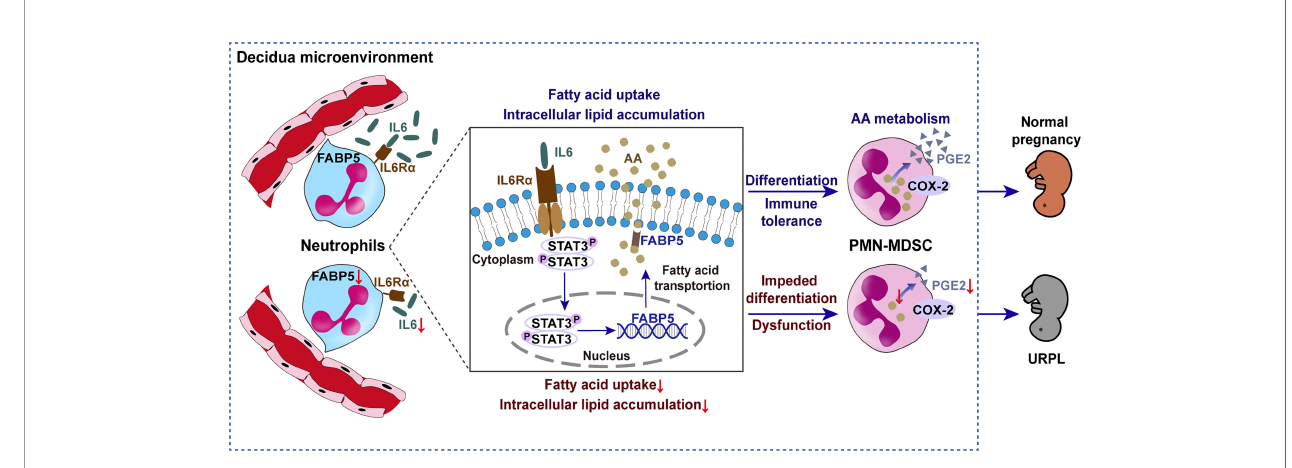
FIGURE 9 | Schematic diagram showing the impact of lipid metabolism on the differentiation of decidual PMN-MDSCs between NP and URPL. Decidual-derived IL6 induced arachidonic acid uptake and intracellular lipid accumulation and then promoted PGE2 synthesis and immunosuppressive PMN-MDSC differentiation in the decidua via pSTAT3/FABP5/COX-2/PGE2 signaling. Factors resulting in lipid metabolism dysfunction can lead to impaired PMN-MDSCs differentiation and function in